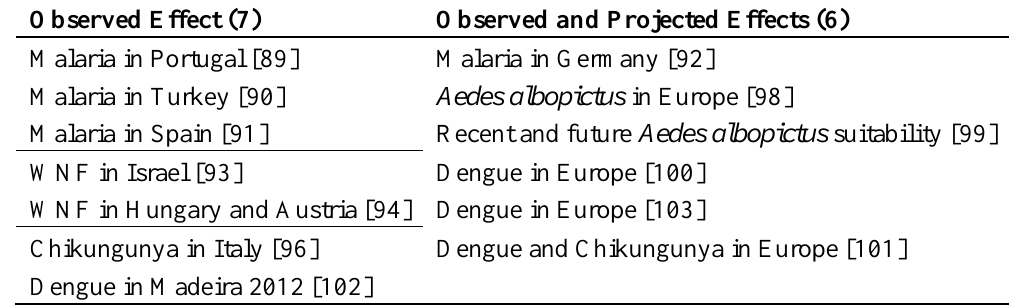
Table 7. Search results (13) of literature about climate change and mosquito-borne infectious